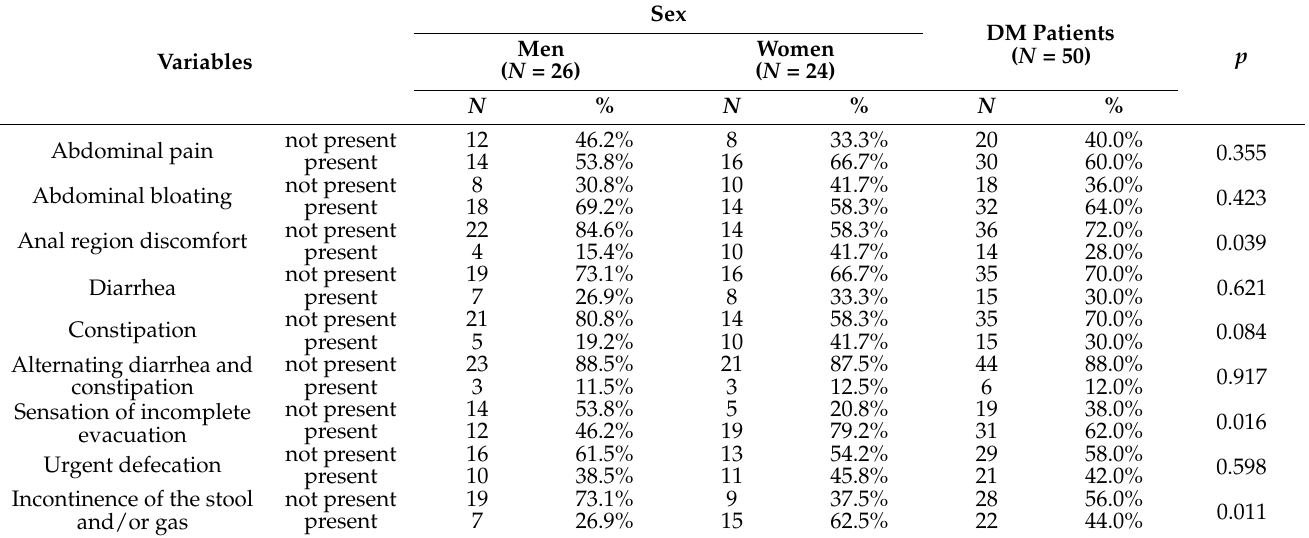
Table 3. The frequency of gastrointestinal symptoms in diabetic patients with gender distribution.